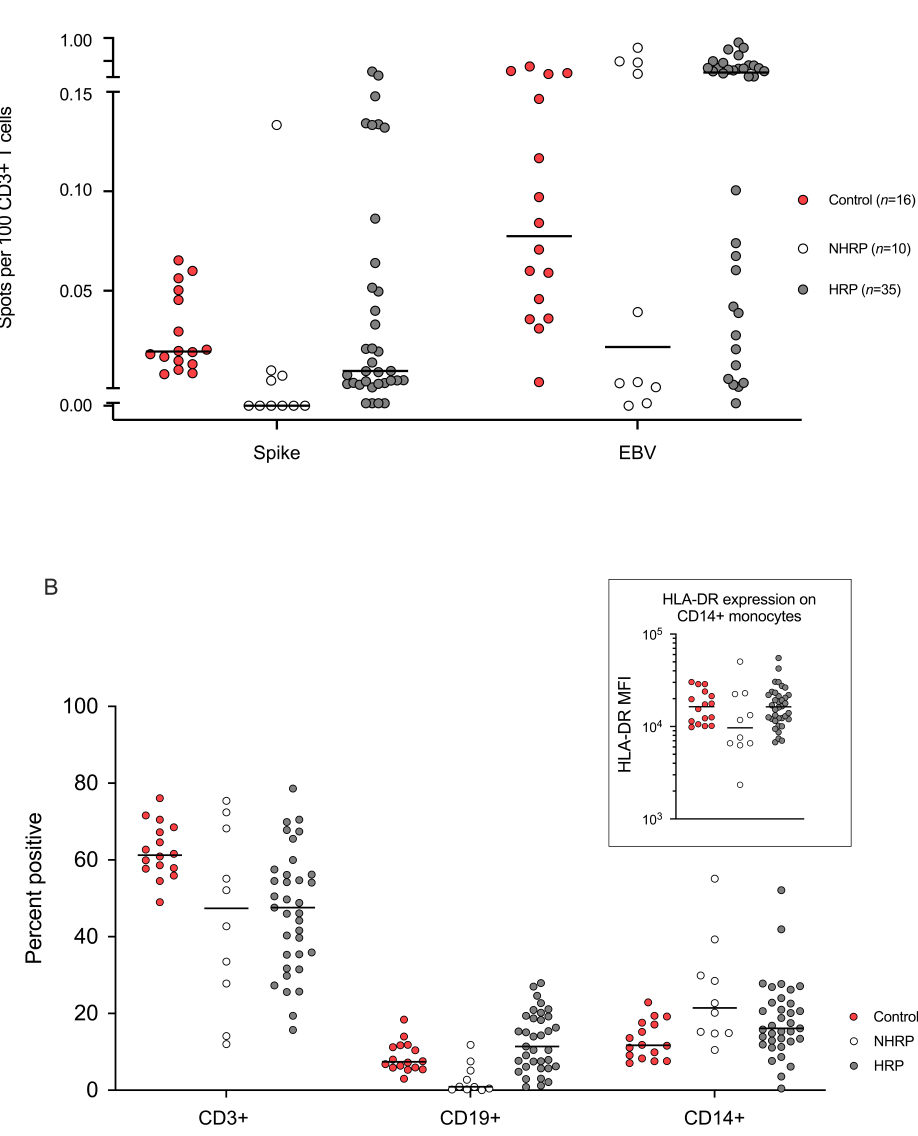
Figure 1. Anti-SARS-CoV-2 Spike T-cells analysis in 45 Allo-HSCT recipients (AML n = 26, MDS n = 19) with humoral (HRP n = 35) or no humoral (NHRP n = 10) response and healthy controls ( n = 16) after two injections of the BNT162b2 mRNA vaccine. Panel ( A ) shows the number of IFN γ Figure 1. ( A ) HDACi pharmacophore model illustrated on the FDA-approved drug vorinostat spots per 100 CD3 + T cells after stimulation of PBMC stimulated with Spike or EBV-consensus peptide; (SAHA). ( B ) Chemical structure of dihydroartemisinin (DHA). ( C ) Compound design based on ( B ) PBMC phenotype analysis used for the ELISpot assay. Results show population frequencies among DHA as cap connected by C-10 ether or thioether groups to four different linkers and three zinc- viable CD45 + cells. Horizontal lines indicate median binding groups.